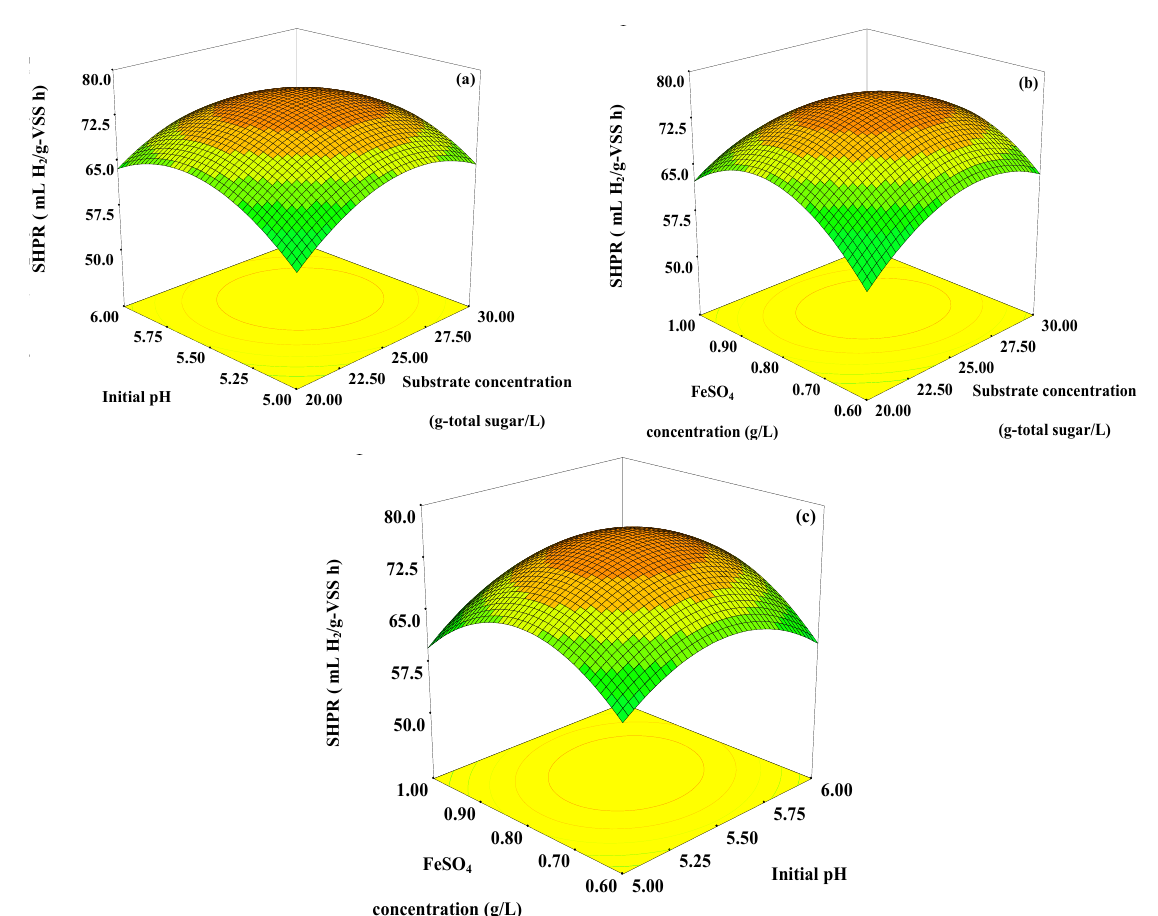
Figure 2. Response surface plots showing: ( a ) the effects of initial pH, substrate concentration, and their mutual interaction on SHPR with optimum level of FeSO 4 concentration (0.81 g/L); ( b ) the effects of FeSO concentration, substrate concentration 4 and their mutual interaction on SHPR with optimum level of initial pH (5.50); and ( c ) the concentration, initial pH and their mutual interaction on SHPR with effects of FeSO 4 optimum level of substrate concentration (25.06 g-total